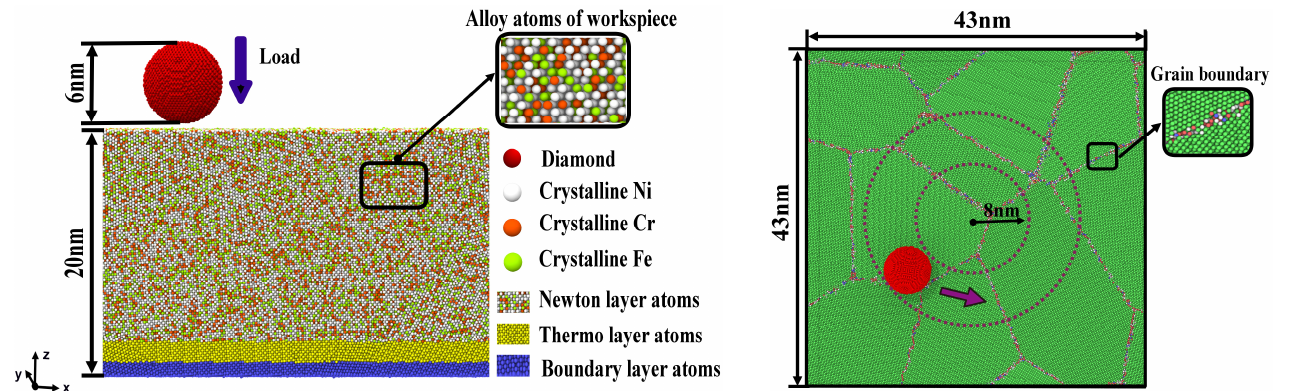
Figure 1. Friction principle experimental device.